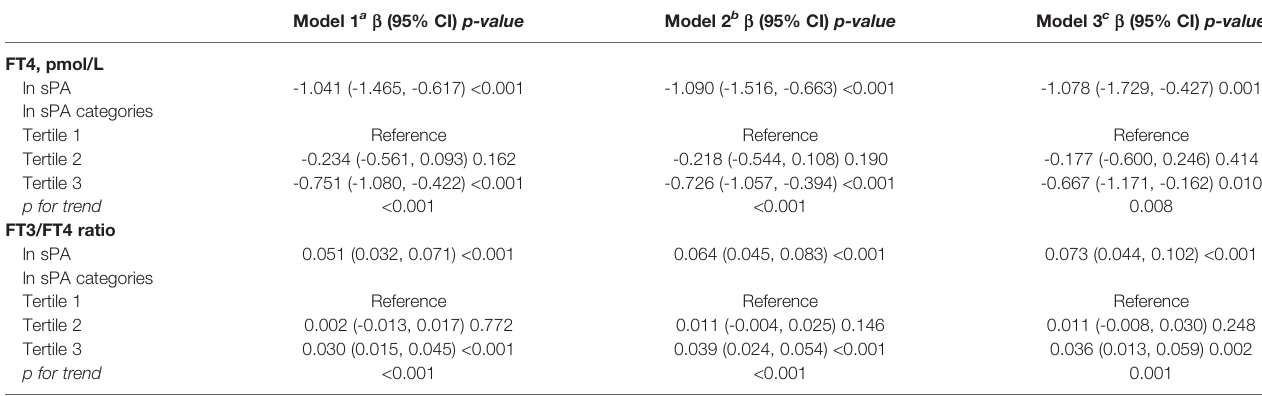
TABLE 2 | The association between ln sPA and FT4, FT3/FT4